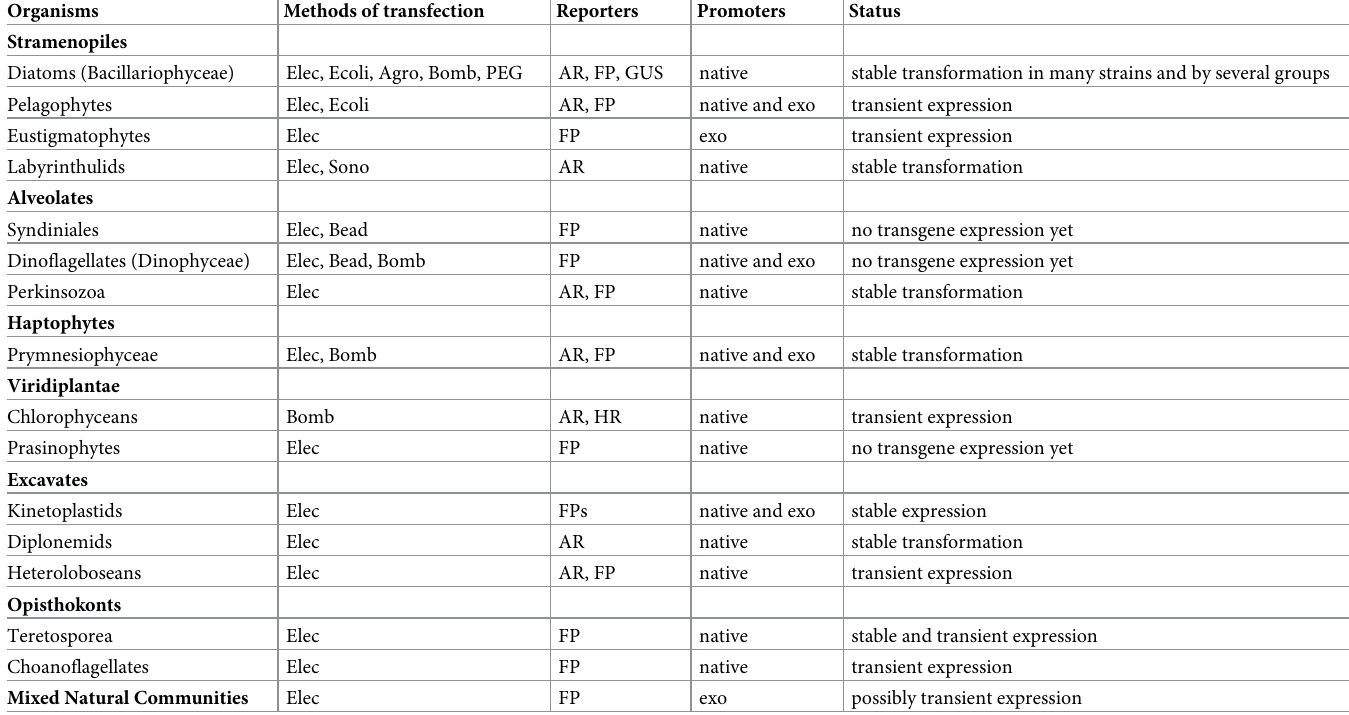
Table 1. EMS investigators’ survey